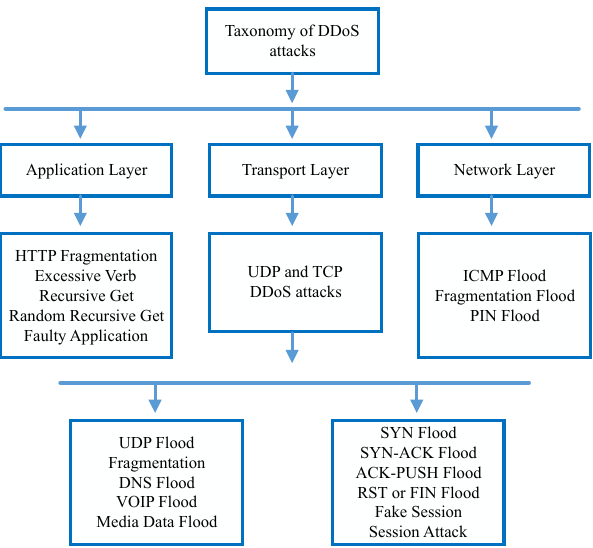
Figure 1. Taxonomy of TCP/IP model DDoS